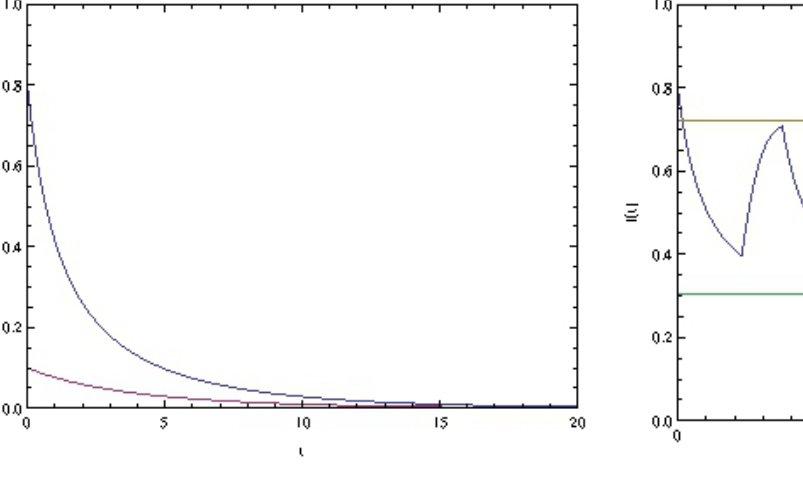
The time evolutions of the density of infection with I (0) =